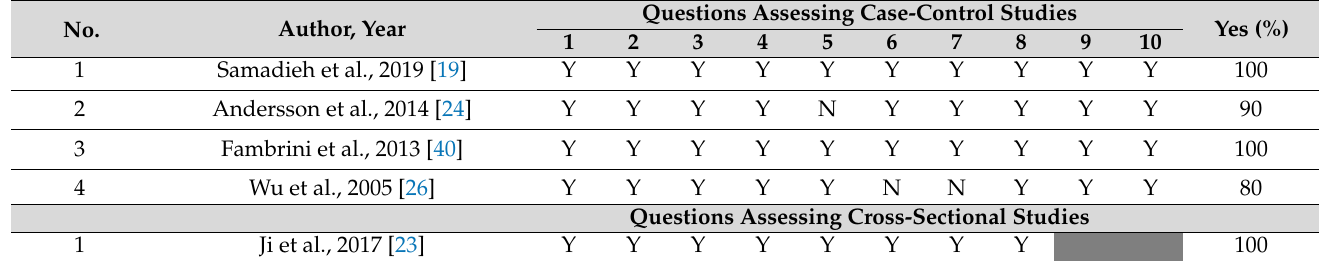
Table A1. Quality assessment of the included